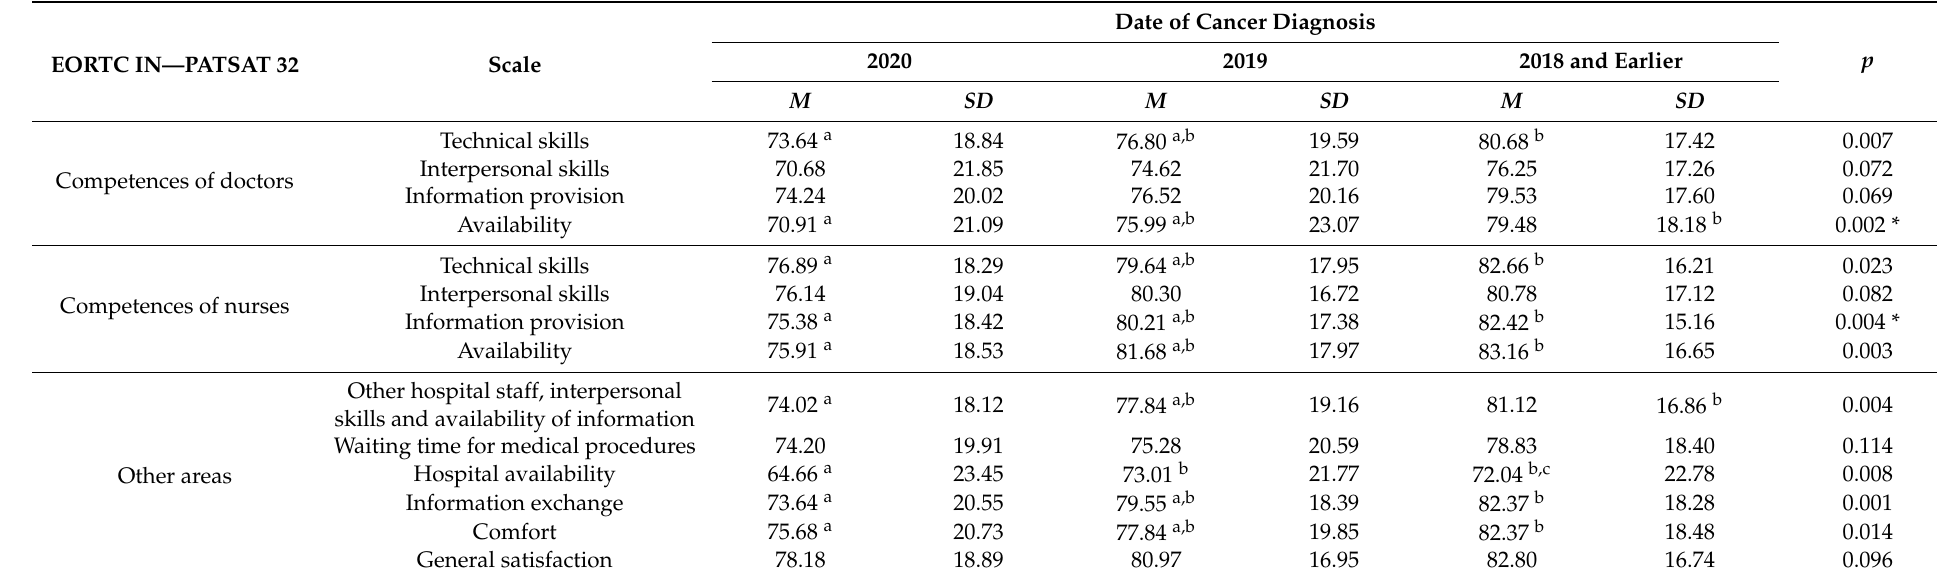
Table 5. Satisfaction with oncological care and the date of cancer